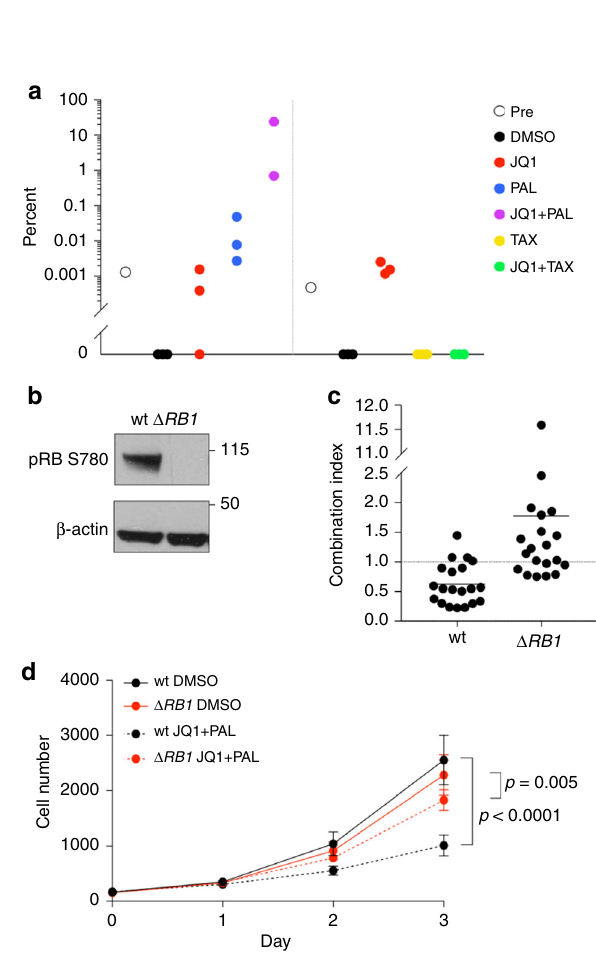
Fig. 4 Rb loss is one possible mechanism of resistance to JQ1 + palbociclib. a Frequency of RB1 E864* mutation detected by ddPCR in pre- treatment cell populations and after selection with JQ1, palbociclib, and paclitaxel, alone and in combinations. Source data are provided as a Source Data fi le. b Western blots show pRB levels in wild-type and RB1 -deleted SUM159 cells. c Levels of synergism between JQ1 and palbociclib in wild- type and RB1 -deleted cells at various doses. Each point represents the combination index (CI) for one pair of concentrations, averaged over eight replicates. CI = 1 additive, CI < 1 synergistic, and CI > 1 antagonistic. Source data are provided as a Source Data fi le. d Growth curves of wild-type and RB1 -deleted cells treated with DMSO or 77 nM JQ1 + 611 nM palbociclib. Data are represented as mean ± SD, n = 68 for DMSO and n = 8 for JQ1 + palbociclib, one-way ANOVA followed by Sidak ’ s multiple comparisons test. Source data are provided as a Source Data fi